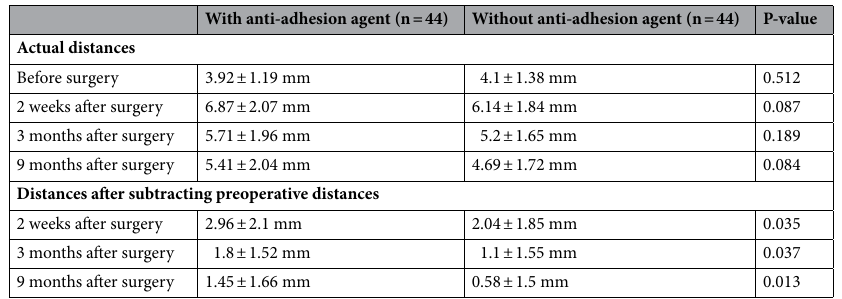
Table 2. Image marker distance migrated in patients who underwent thyroidectomy with and without an anti- adhesion agent.